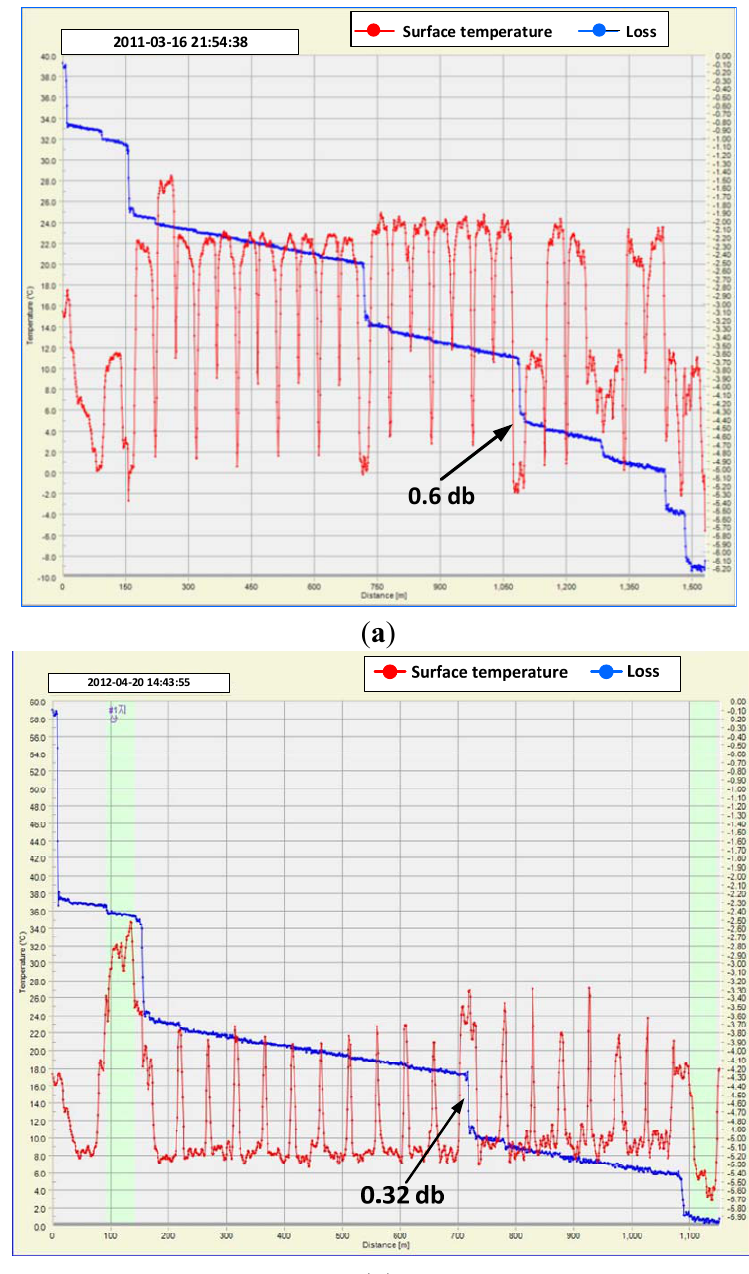
Figure 16. DTS optical loss measurement for optical switch: ( a ) before and ( b ) after the